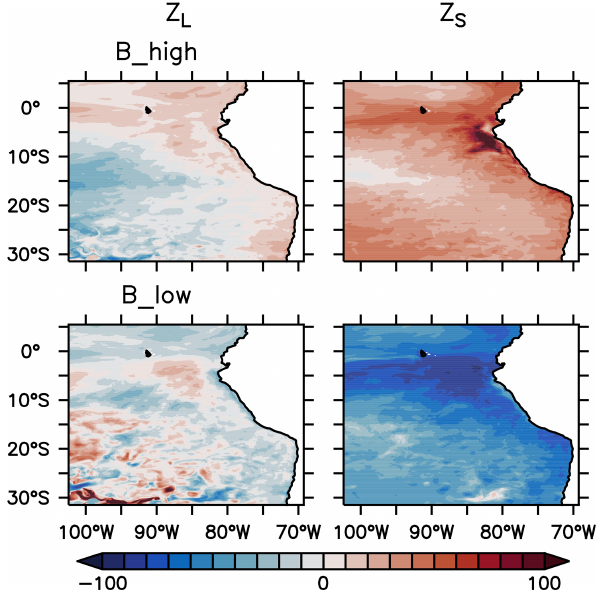
Figure 7. Percentage normalised difference in the nitrogen flux from large and small zooplankton to detritus due to zooplankton mortality, integrated over the upper 100m of the water column, be- tween experiment B_high and experiment B_low and the reference scenario (see Fig. 3 for the reference